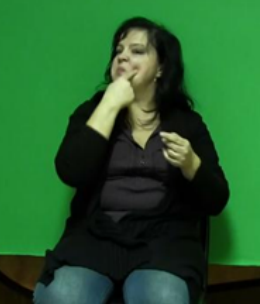
Figure 1. The equivalent of the English sentence “He is offended” in Russian Sign Language (RSL) with the pronoun on the left hand and the sign offended on the right